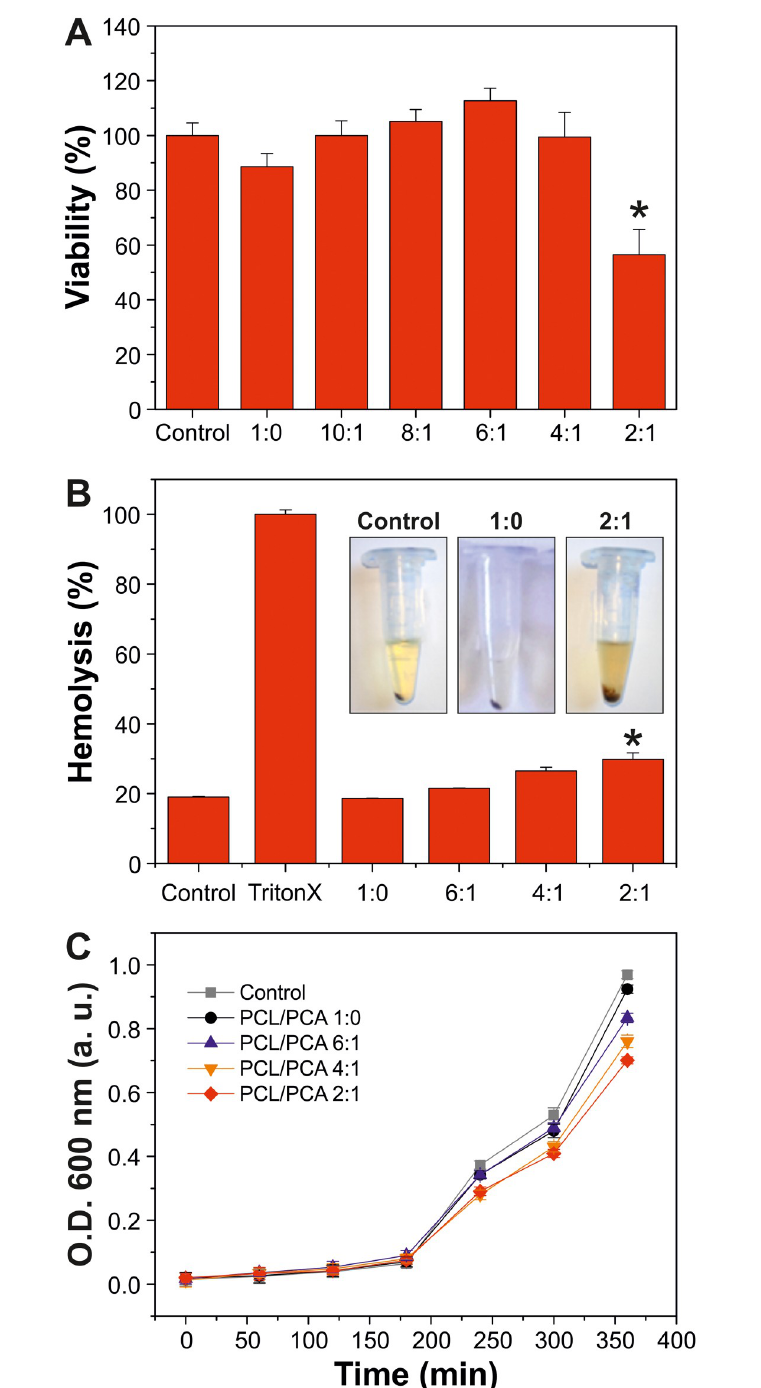
Fig 6. Biocompatibility, hemocompatibility and antibacterial properties of the biomaterials. (A) Histogram of MTS assay of cells incubated for 72 h with the PCL/PCA films at different mole ratios. The control sample does not present any PCL/PCA materials. � p < 0.05 vs control. (B) Histogram relative to the absorbance of released Hb after treatment with PCL/PCA films 1:0, 6:1, 4:1, and 2:1. The values are expressed as the percentage respect to the positive control (TritonX). � p < 0.05 vs control. The insets show the photographs of human erythrocytes incubated with the control and PCL/PCA 1:0 and 2:1 after centrifugation. (C) Growth curve of E . coli in the presence of PCL/PCA 1:0, 6:1, 4:1, and 2:1 films. The control sample does not present any PCL/PCA materials.